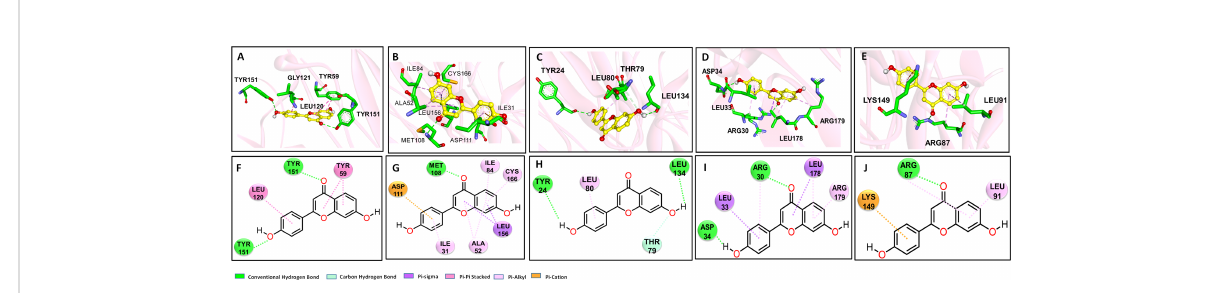
FIGURE 5 Molecular docking analysis to predict the binding modes between DHF and its therapeutic targets. Based on the gene expression results in the esophagus, the binding explorations of complex MAPK1-DHF, IL1B-DHF, IL6-DHF, TNF-DHF, CCND1-DHF were explored. Predicted lowest- energy binding mode of DHF in 3-dimentiaonal fi gure with the following proteins: (A) , (F) TNF- a ; (B) , (G) MAPK1; (C) , (H) IL1B; (D) , (I) IL6; (E) , (J) CCND1; the carbon, oxygen and nitrogen are highlighted in yellow, red, and blue, respectively. For residents of proteins, the green, red, and blue stand for C, O and N,